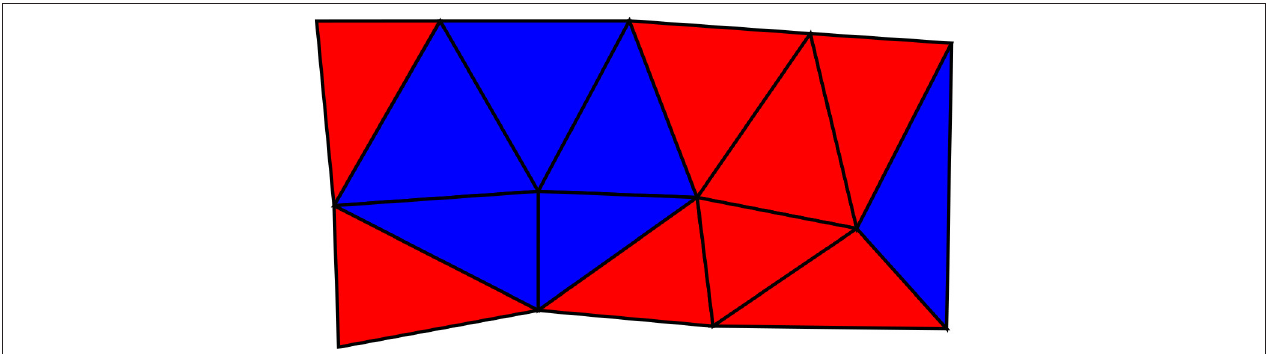
T MHD and red elements K ∈